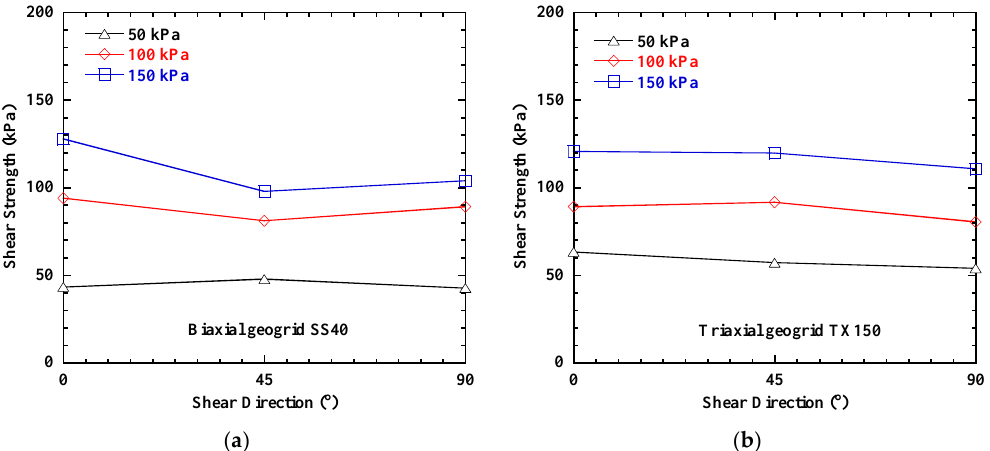
Figure 13. The influence of shear direction on the shear strength of coarse sand–biaxial geogrid (SS40) and coarse sand– triaxial geogrid (TX150) interfaces. ( a ) SS40, ( b ) TX150.